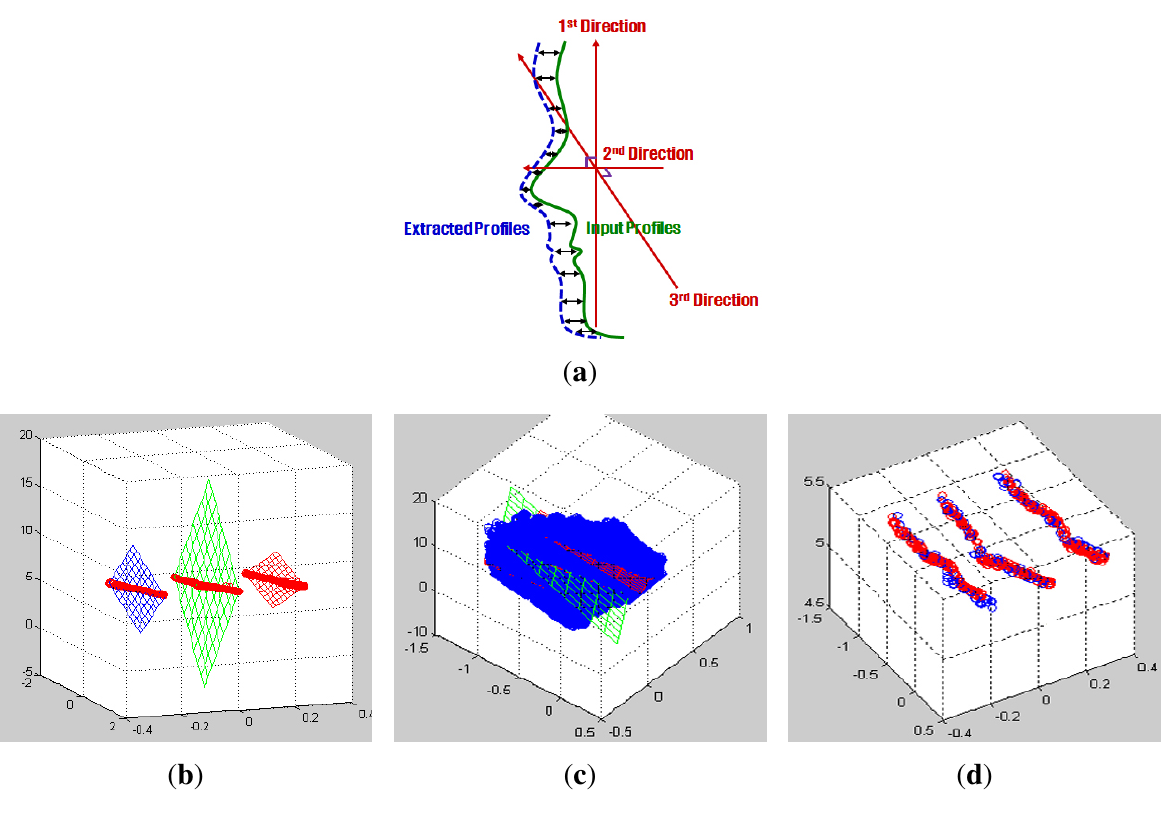
Figure 13. Method for extracting the corresponding profile from full 3D face data. ( a ) Direction of eigenvector corresponding to the first and second largest eigenvalues; ( b ) planes generated by profiles; ( c ) intersection of profile and full 3D face data; and ( d ) corresponding profile